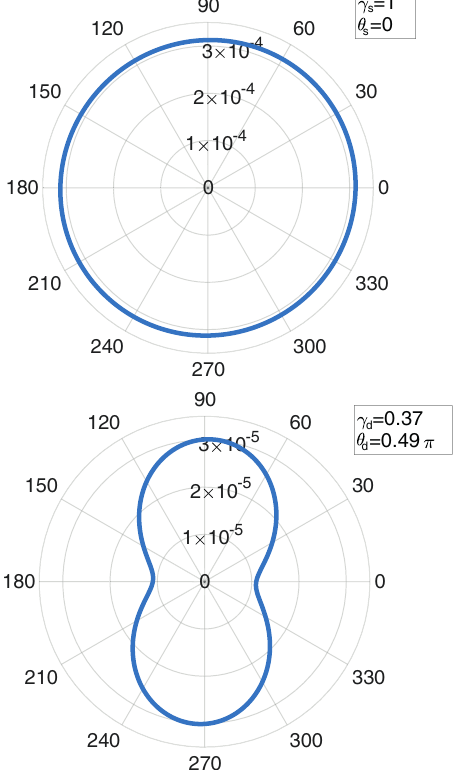
Figure 3. Polar plots of m 2 ( θ ) for the rigid surface ( on the top ) and µ 2 ( θ ) for the deformed half-space ( on the bottom ). Calculations are carried out for a constant normal pressure p equal to p = 32 kPa and a dimensionless speed equal to v τ / L 0 = 0.13.